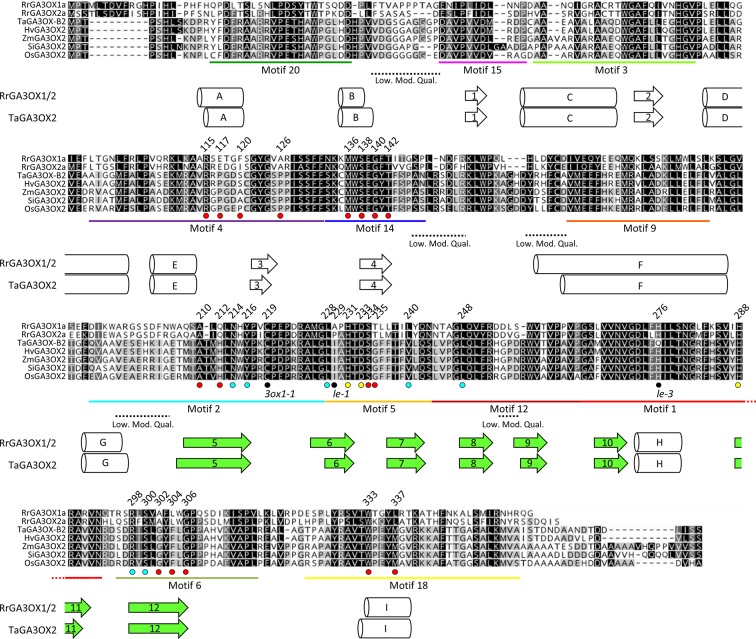
Sequence alignment comparing RrGA3OX1a and RrGA3OX2a against TaGA3OX2 and its orthologs from several other monocot species. MUSCLE generated protein sequence alignment. Shading denote amino acids with similar properties (based on ≥1 Blosum62 matrix score) and their prevalence across the seven sequences (black 100%; dark gray 80–100%; light grey 60–80%; white < 60%). Predicted secondary structures underlie the involved residues (arrows = β-strands; cylinders = α-helices). β-strand secondary structures 5–12 (shaded green) form the “jelly-roll” motif reaction cavity in which docks the co-factor FE(II) ion, 2-oxoglutarate co-substrate (2OG), and the bio-inactive GA precursor molecule. MEME identified sequence motifs from Figure 6C, are underlined, labeled, and color matched in accordance with Figure 6C. Substrate contact residues identified in Figures 8E, F are indicated by dots below the sequence alignment. Cyan dots = 2-oxoglutarate binding residues. Yellow dots = Fe ion binding residues. Red dots = 12 residues predicted to be capable of making contact with the docked GA substrate. Additional residues of interest; black dots = residues altered in Arabidopsis (3ox1-1) and pea (le and le-3) ga3ox mutants. Dashed lines underline regions of lower modeling quality (Low. Mod. Qual.); i.e., higher root-mean-square deviation (RMSD) in atomic positions between the RrGA3OX1a and TaGA3OX-B2 protein tertiary structures with the modeling template.